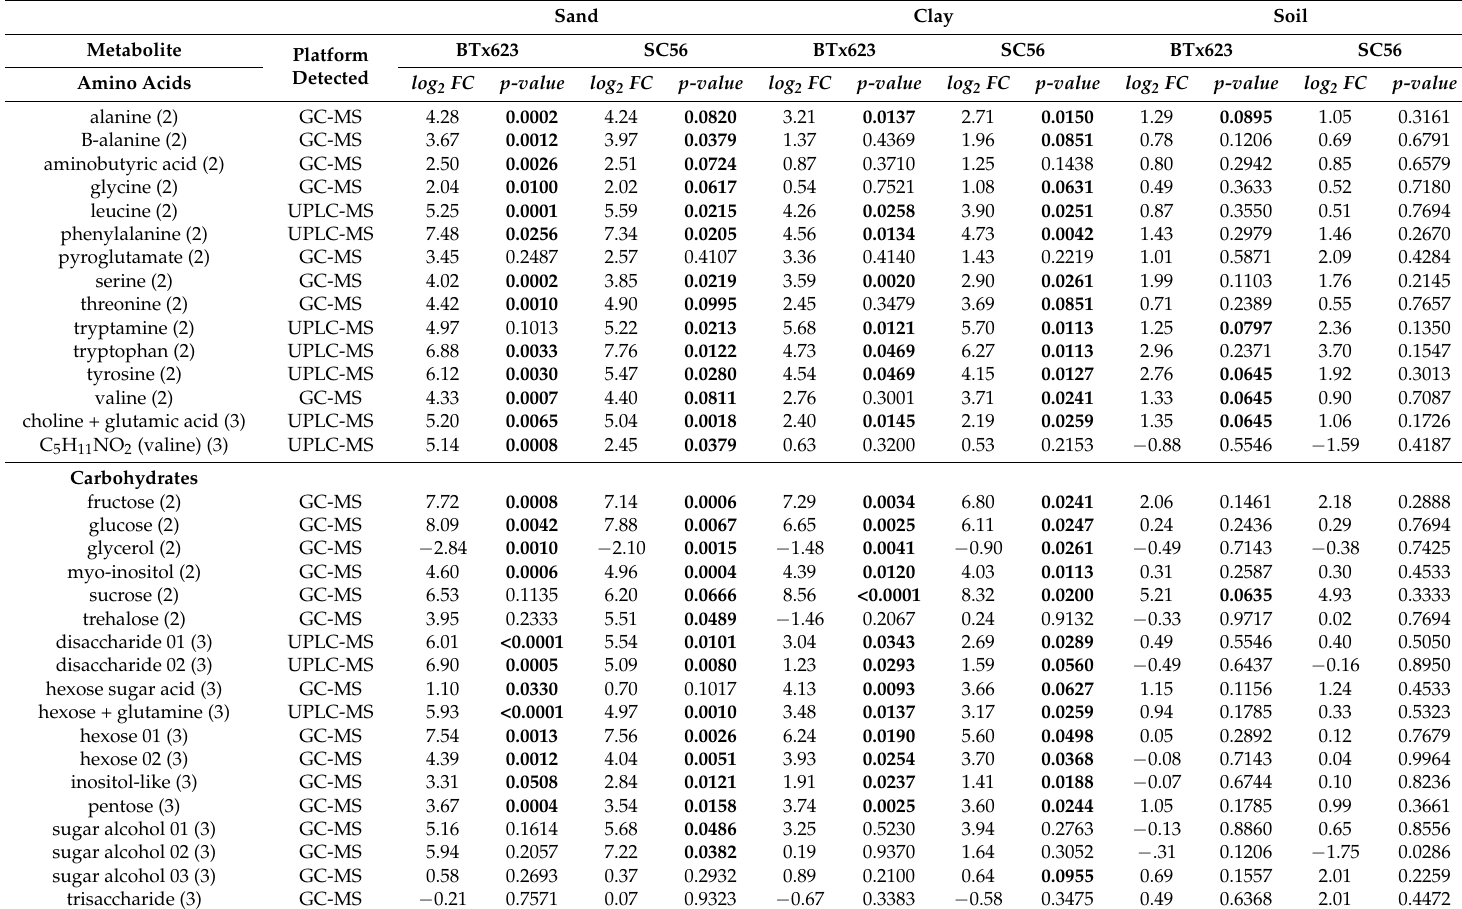
Table 2. Annotated metabolites. List of annotated metabolites grouped by amino acids, carbohydrates, organic acids, vitamins, and others along with the platform detected, GC- or UPLC-MS and annotation confidence in parentheses. Metabolites that were annotated at a chemical class level are numbered if there are multiples (i.e., disaccharide 01, disaccharide 02). Associated log 2 fold changes and false discovery rate (FDR) adjusted p -values for each genotype within each substrate are displayed. Bolded p -values are less than